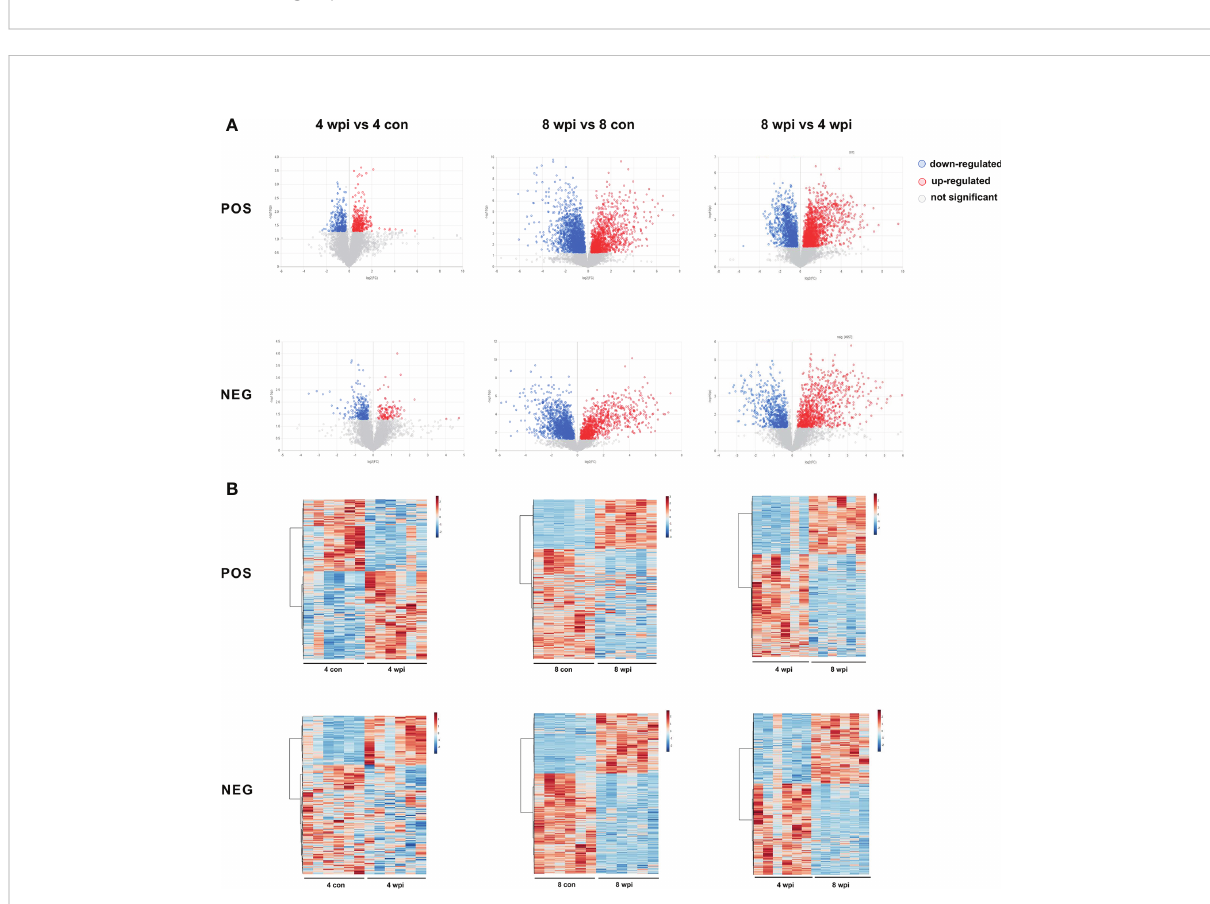
FIGURE 2 Differential metabolites were identi fi ed among different groups in ESI+ and ESI − modes. (A) Volcano plots showed signi fi cant differences among different groups. Each point in the map represents a metabolite. The size of the scatter represents the VIP value of the OPLS-DA model, and the larger the scatter, the larger the VIP value. (Red plot, up-regulated; Blue plot, down-regulated; Black plot, non-signi fi cant). (B) Heat maps representing the signi fi cantly changed metabolites between infected groups and the corresponding control groups. Each row represents data for a speci fi c metabolite, and each column represents a rat ( C. sinensis- infected or healthy control). Different colors correspond to the different intensity levels of metabolites. Red and blue colors represent increased and decreased levels of metabolites,